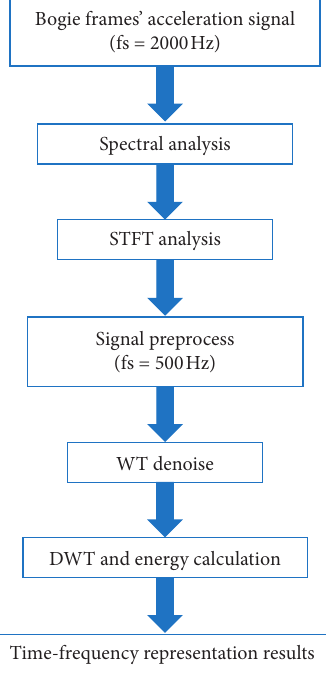
Figure 4: Time-frequency analysis process of the test signal.